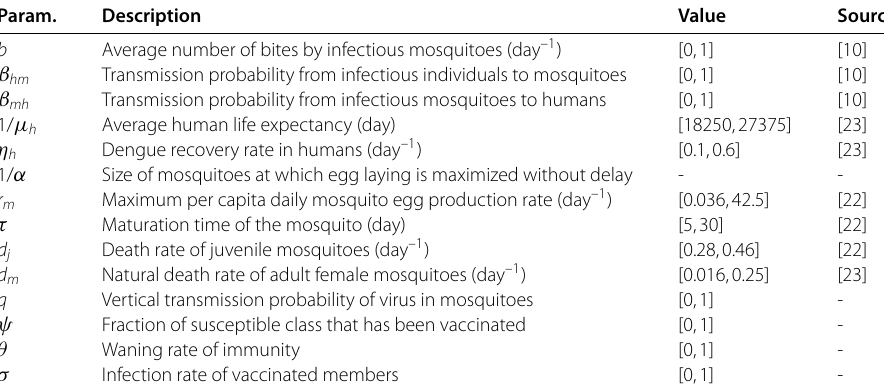
Table 1 Parameter interpretations, value ranges and sources of model (1)